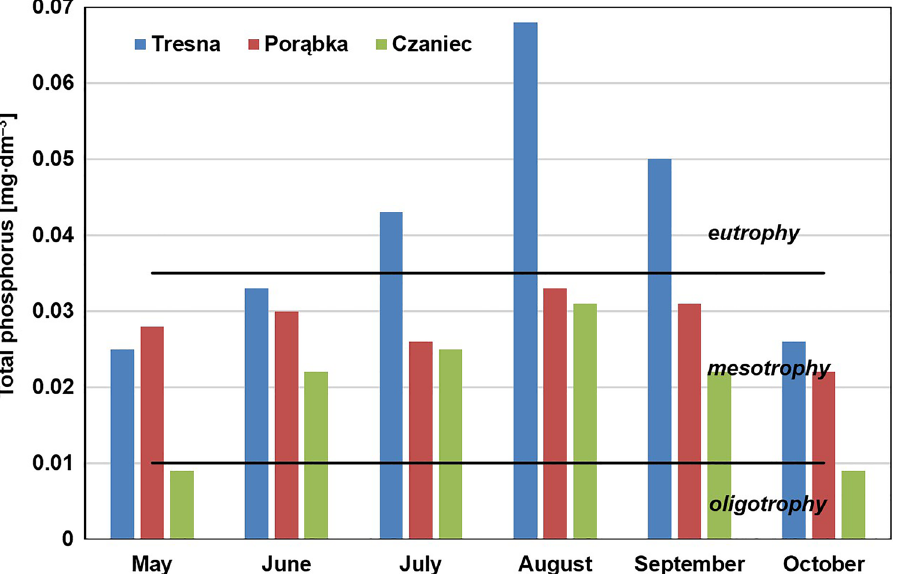
Figure 8. Concentrations of the total phosphorus in water of the Soła cascade reservoirs in 2019 year and the OECD trophic classification 11